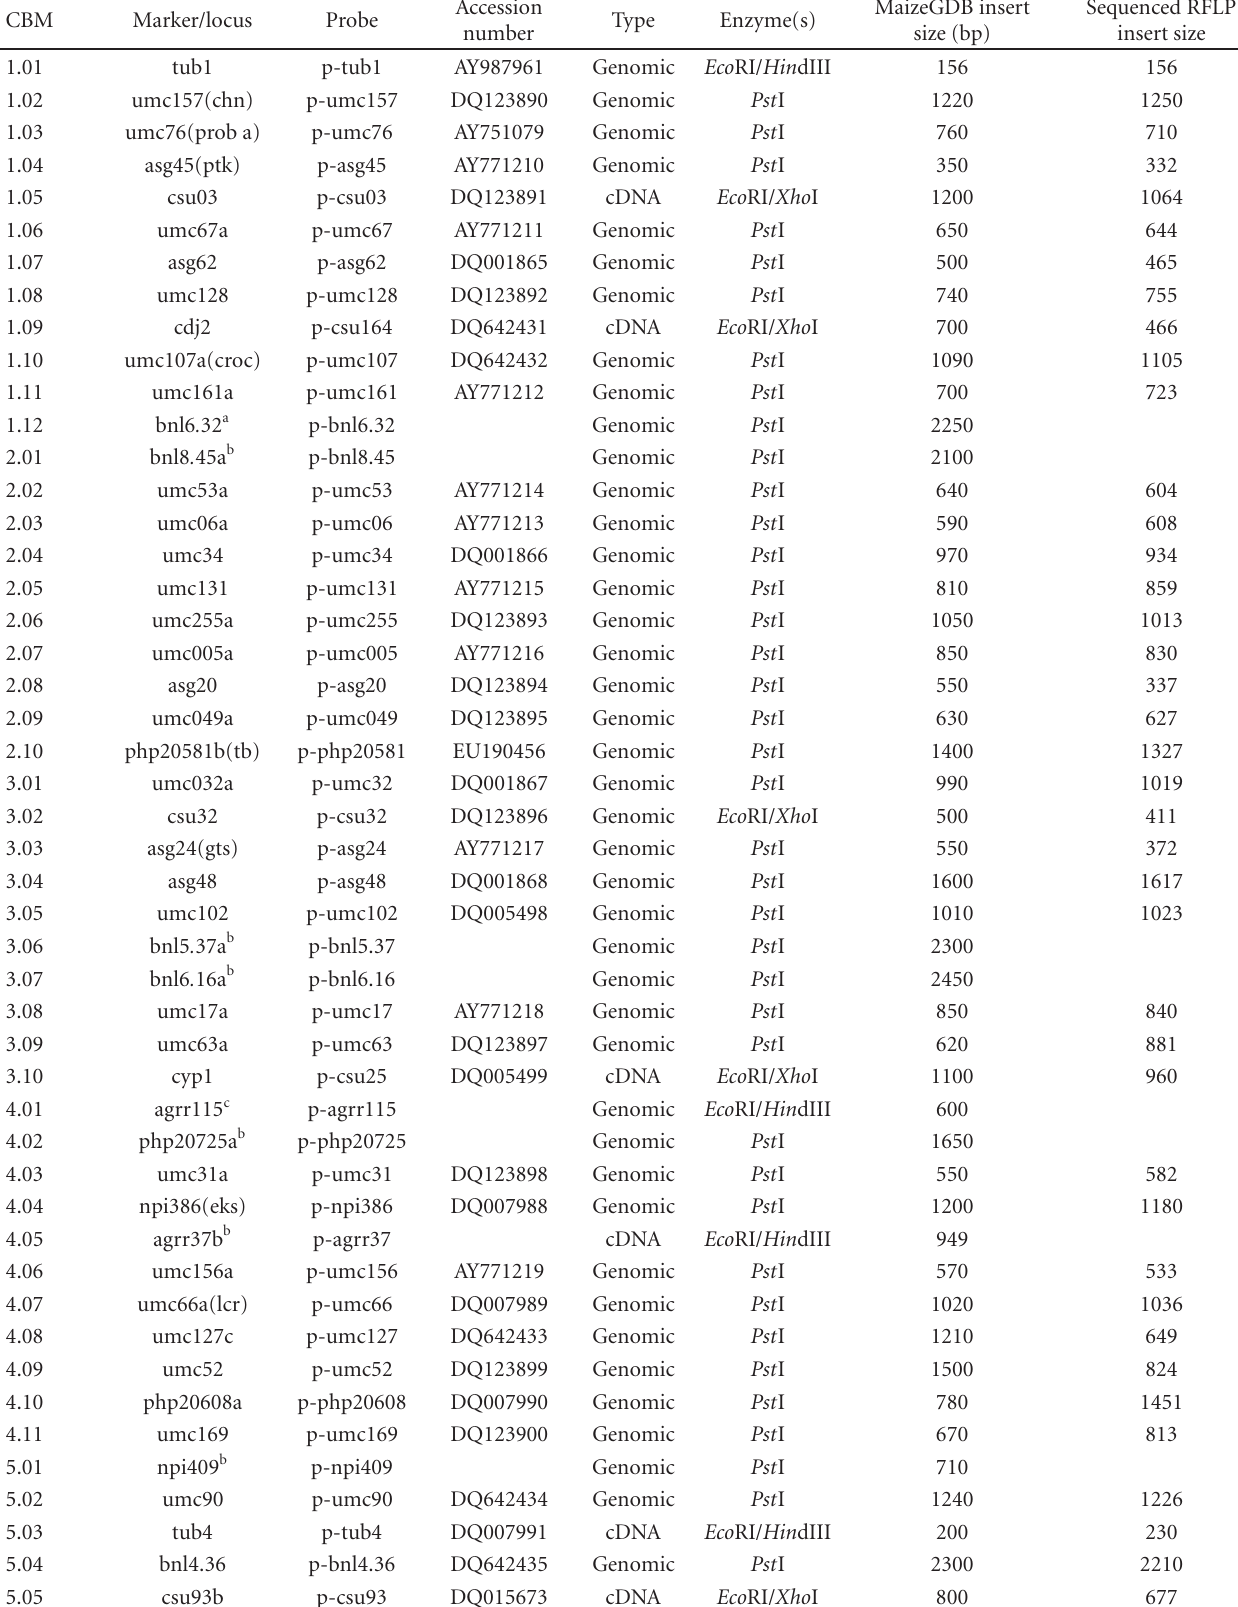
Table 1: Sequenced maize